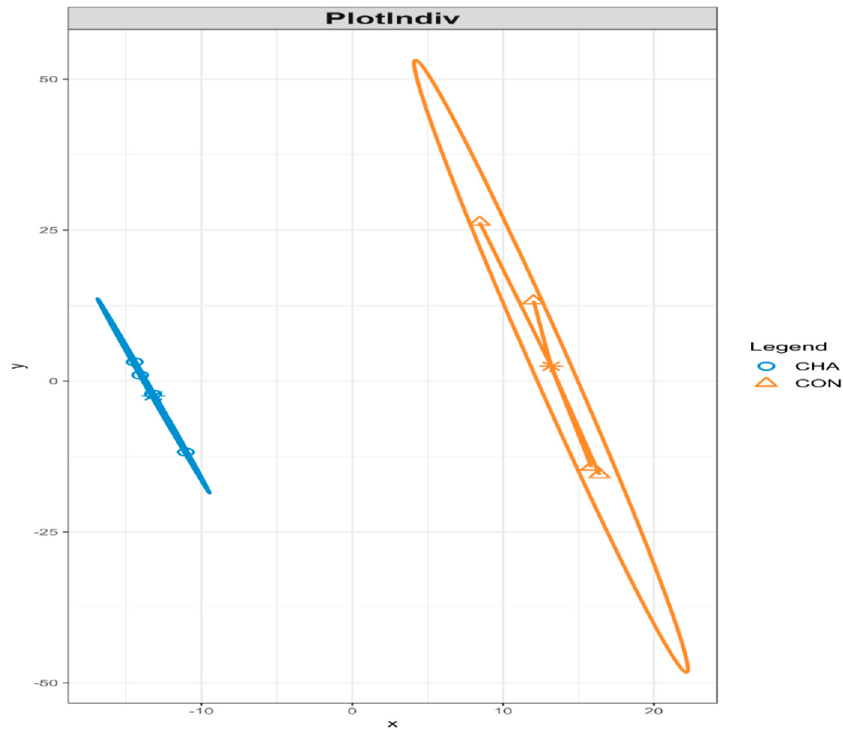
Figure 5. Partial least squares discriminant analysis of functional gene expression profiles in beef cattle during acidosis challenge. CHA = corn-induced acidotic challenge, CON = control (no challenge).